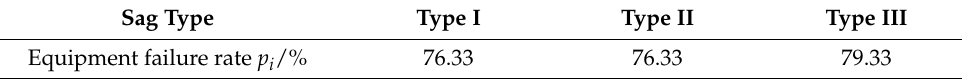
Table 2. Probability value of equipment failure under each sag